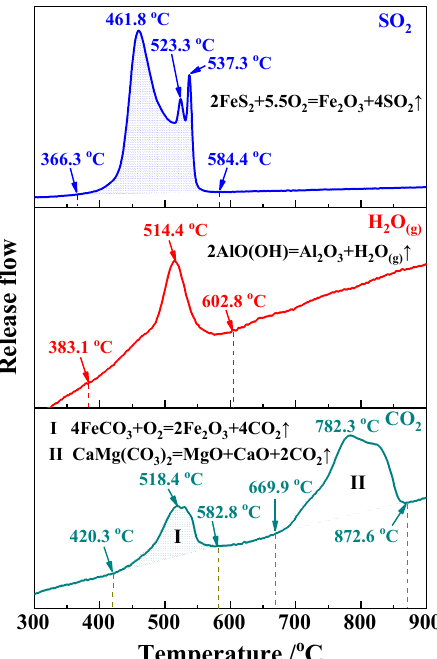
Figure 5. Release flow curves of the gaseous products SO 2 , H 2 O (g) , and CO 2 . As shown in Figure 5, the release of SO 2 is observed in the range of 366.3 °C–584.4 with three overlapping peaks with peak temperatures of 461.8 ◦ C, 523.3 ◦ C, and 537.3 ◦ C